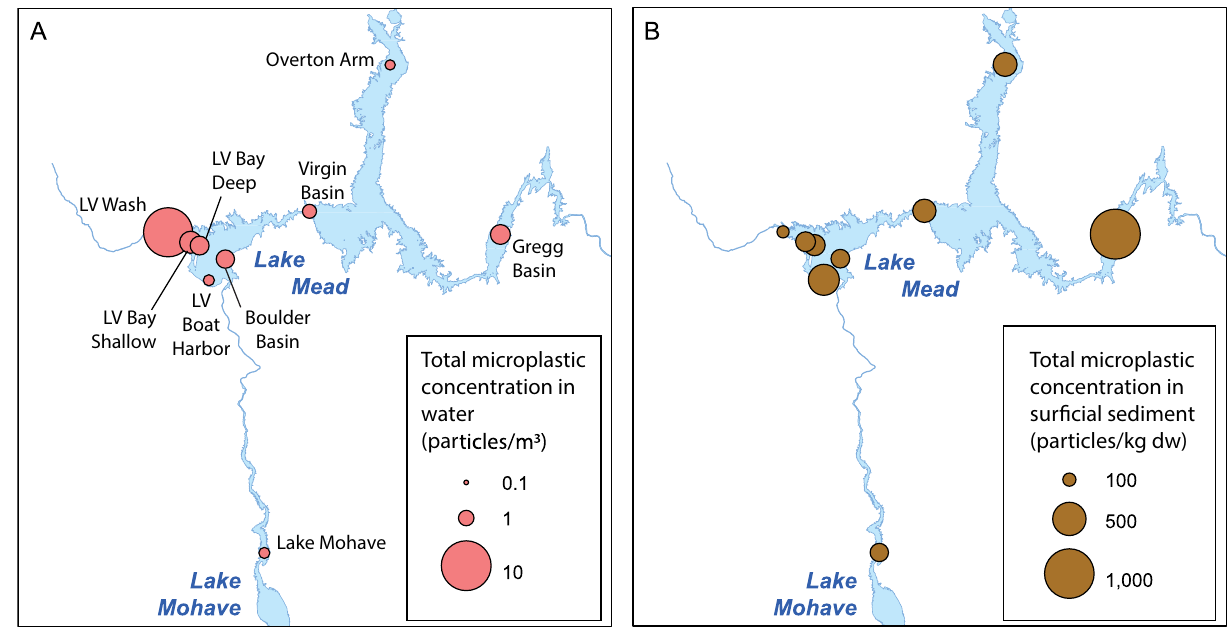
Fig 3. Total microplastic concentrations in (A) water and (B) surficial sediment samples, Lake Mead and Lake Mohave, 2017. Las Vegas Wash (LV Wash) is a stream sample, all others are lake samples. Lake boundaries are from the U.S. Geological Survey National Hydrography Dataset. dw, dry